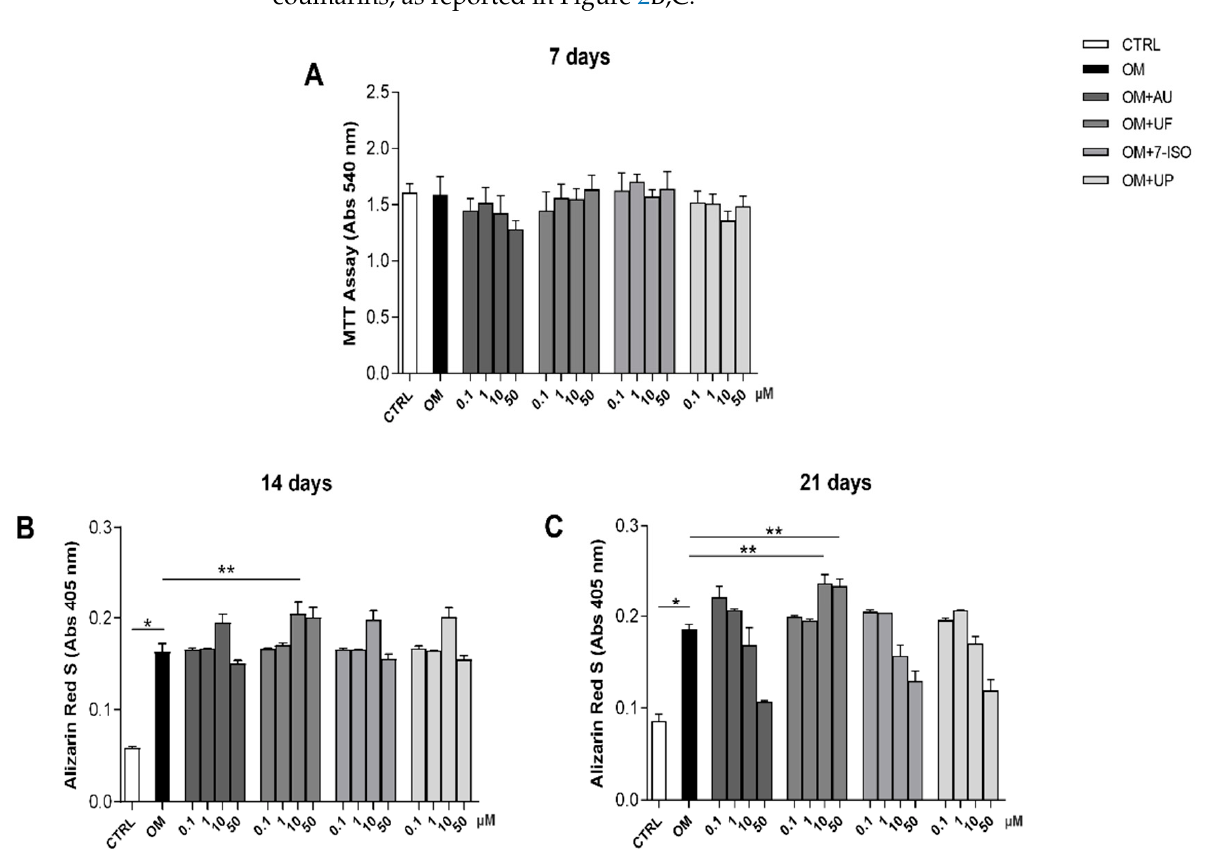
Figure 2. Cells’ metabolic activity and bone matrix deposition: ( A ) Effects of coumarin derivatives (AU, UF, 7-ISO, and UP; 0.1-1-10-50 µ M) on hOBs’ metabolic activity following 7 days of culture. Mineral matrix deposition quantification after ( B ) 14 and ( C ) 21 days of treatment with the molecules. Results are shown as the mean ± error standard (SEM) ( n ≥ 3); * p < 0.05 vs. CTRL; ** p < 0.05 vs. OM